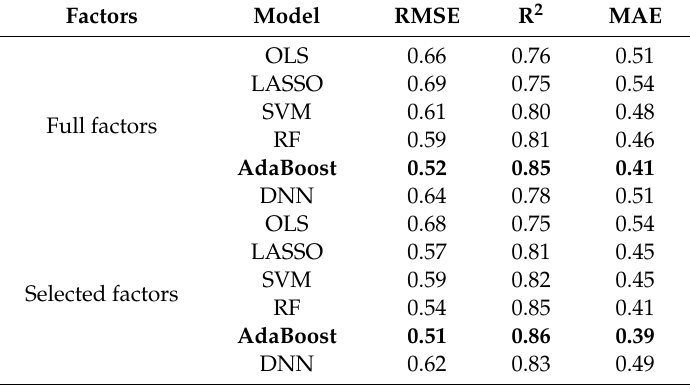
Table 2. The predictive performance of the six models using both full and selected factors (the highest accuracy was highlighted in bold).